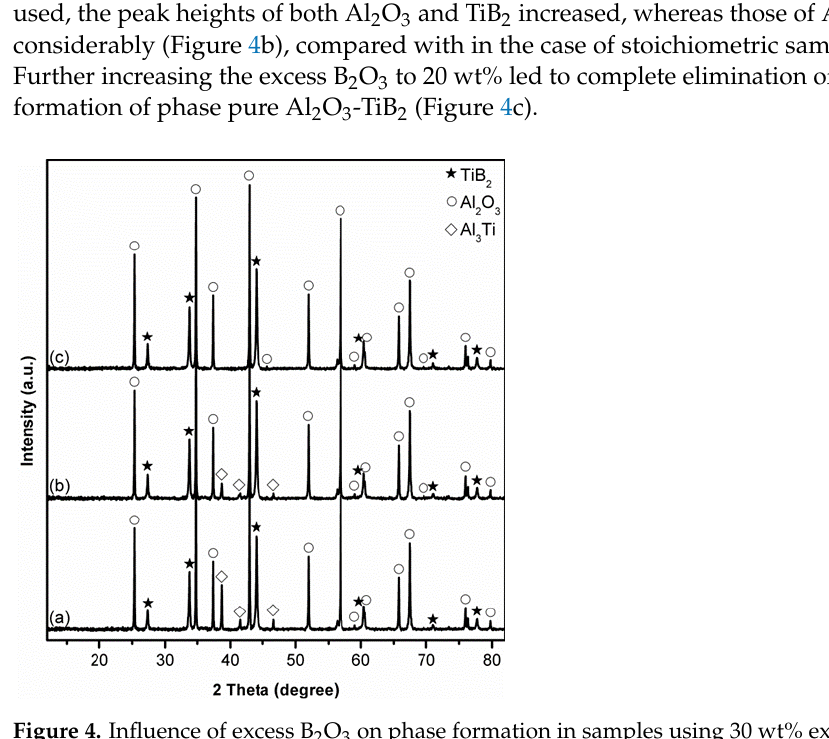
Figure 4. Influence of excess B 2 O 3 on phase formation in samples using 30 wt% excess Al, after 4 h firing in NaCl at 1150 °C: ( a ) 0 (stoichiometric), ( b ) 10, and ( c ) 20 wt% excess B 2 O 3 .